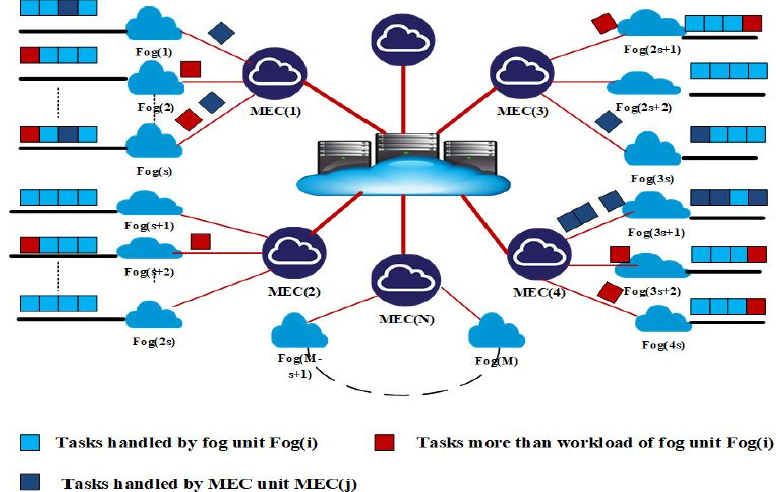
Figure 3. Main levels of the developed fog-MEC scheme.